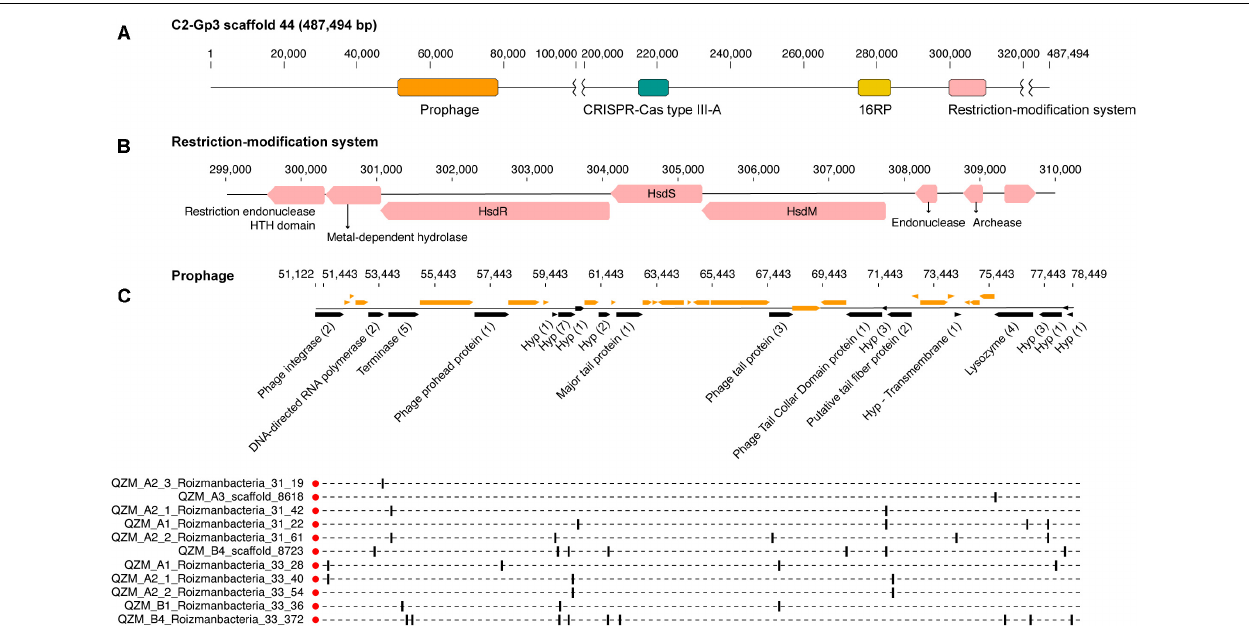
FIGURE 2 | Prophage and restriction modification systems are detected in the genomes of Roizmanbacteria C2-Gp3. (A) Scaffold 44 includes prophage, a restriction-modification system and an apparently degenerate Type III-A CRISPR-Cas system. (B) The proteins in the restriction-modification system shown in (A) . (C) Prophage genes targeted by spacers are shown in black and the number of spacers targeting each open reading frame (ORF) is listed in brackets following the annotation. Genes not targeted by CRISPR spacers are shown in orange (top panel). The genome affiliations of spacers targeting the prophage are indicated in the bottom